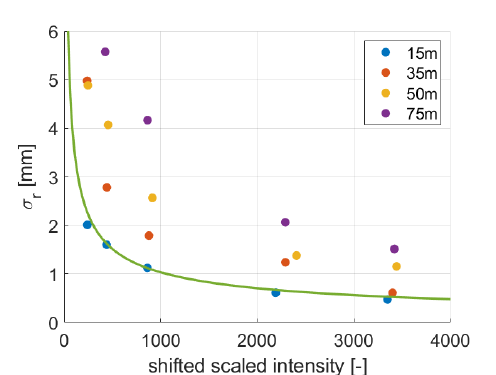
Figure 14. Range precision of samples with higher